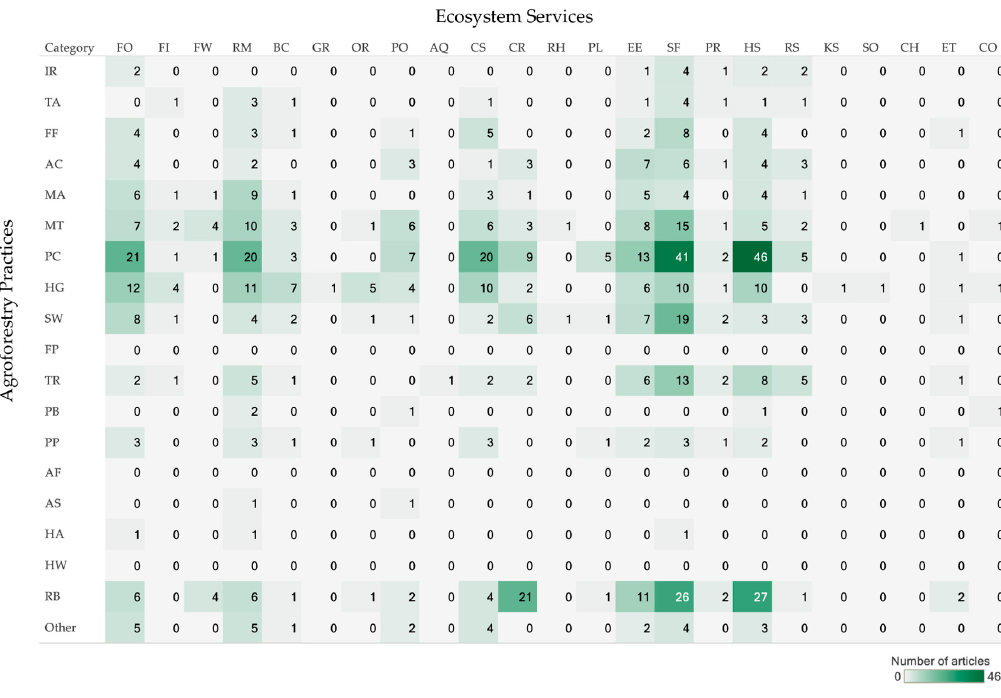
Figure 9. The linkage between agroforestry practices and ecosystem services after 2000. Note: The darker the color of the cells, the higher the frequency of